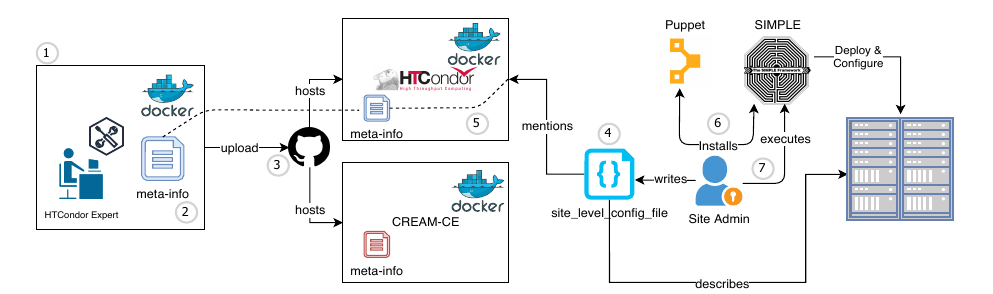
Figure 2: Flow of configuration information in the SIMPLE